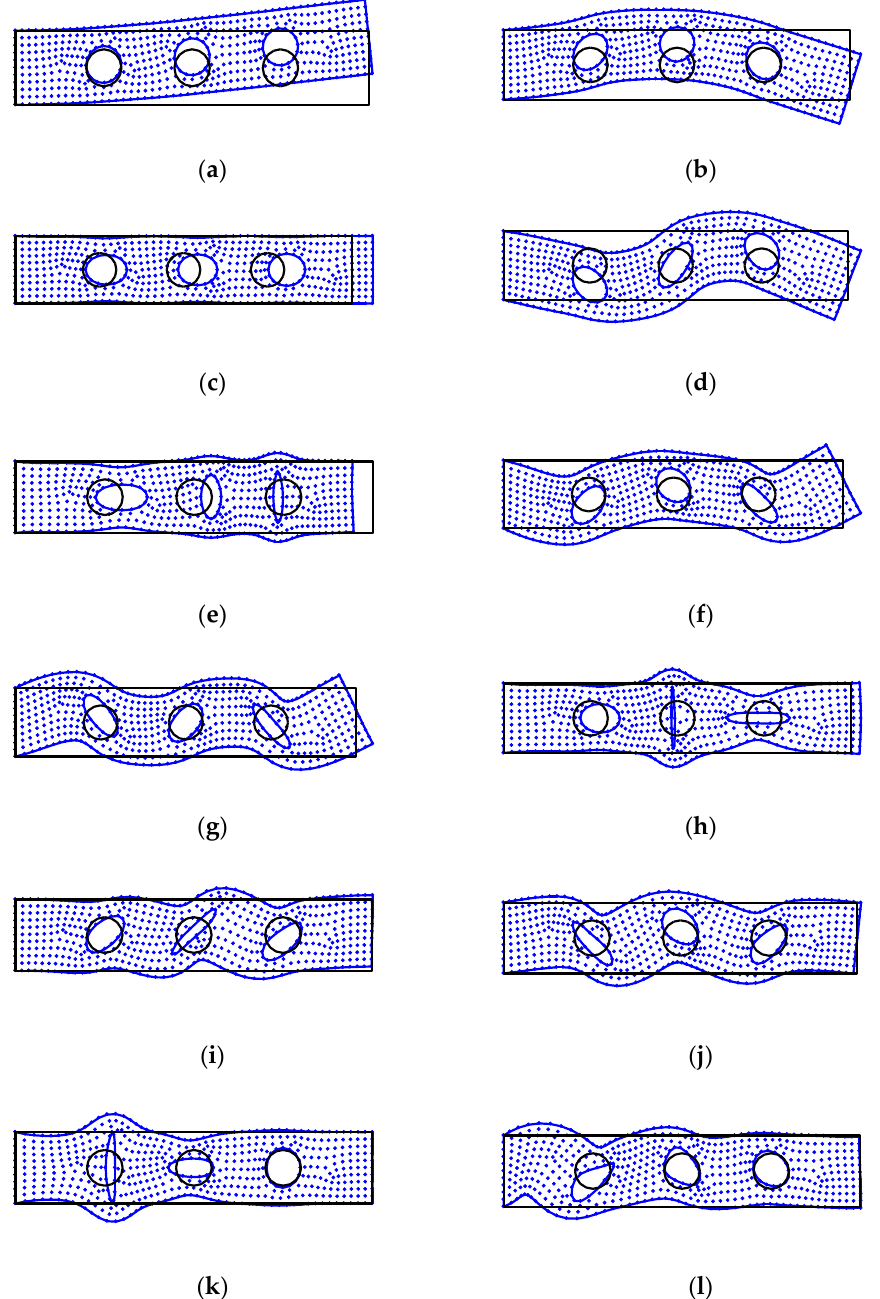
Figure 12. The free vibration modes of the cantilever beam with three identical holes corresponding to the first twelve natural frequency values from the present M-RPIM: ( a ) Mode 1; ( b ) Mode 2; ( c ) Mode 3; ( d ) Mode 4; ( e ) Mode 5; ( f ) Mode 6; ( g ) Mode 7; ( h ) Mode 8; ( i ) Mode 9; ( j ) Mode 10; ( k ) Mode 11; ( l ) Mode 12.